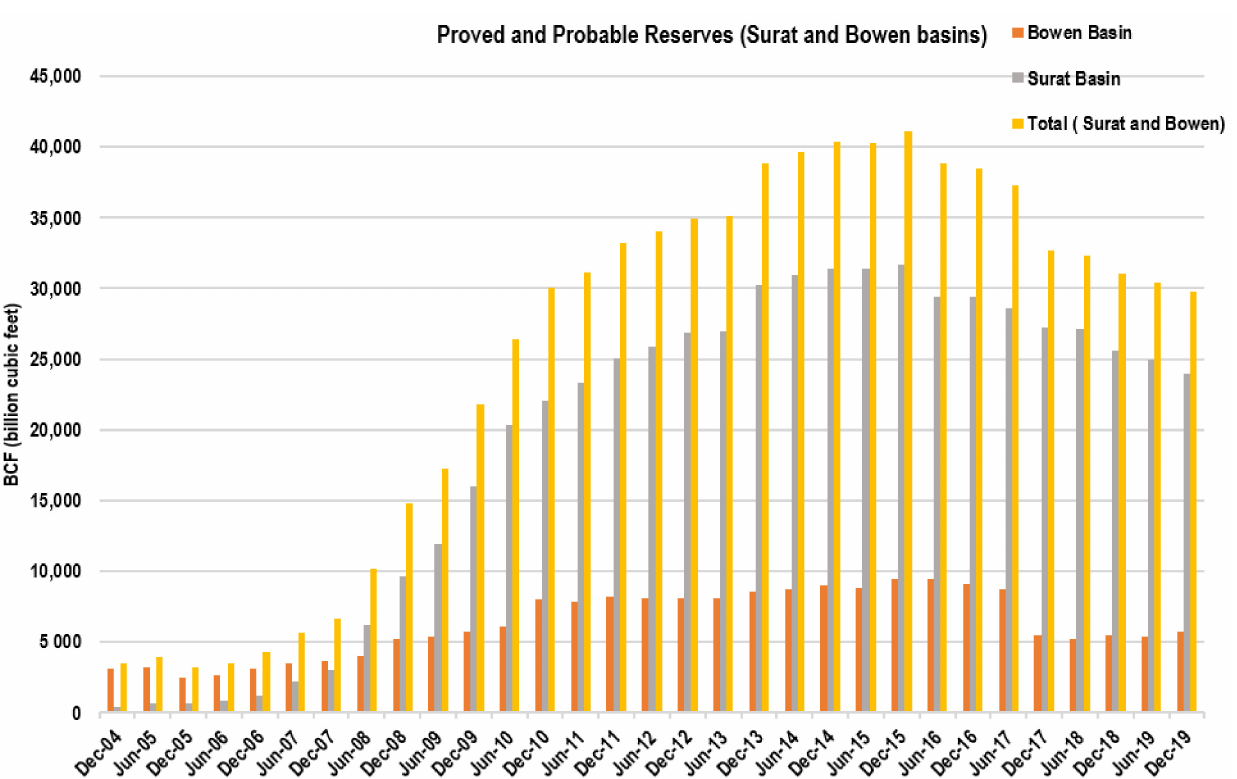
Figure 4. 2P reserves for the Surat and Bowen Basins since 2005